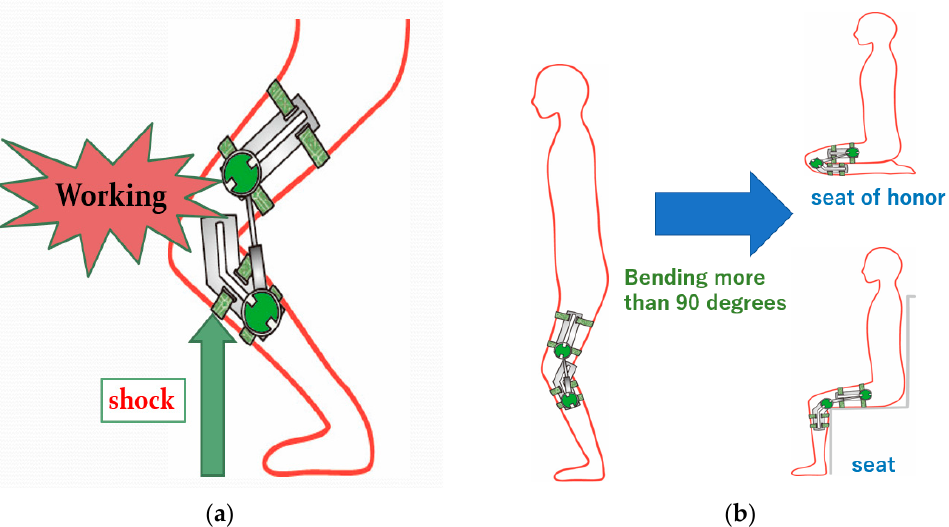
Figure 2 . ( a ) This product is only activated when a shock is applied during knee bending, such as when climbing stairs or running. Therefore, it does not work in the case of normal slow leg bending motions. ( b ) When the knee is bent more than 90 degrees, the product is stowed and can be used to sit upright.